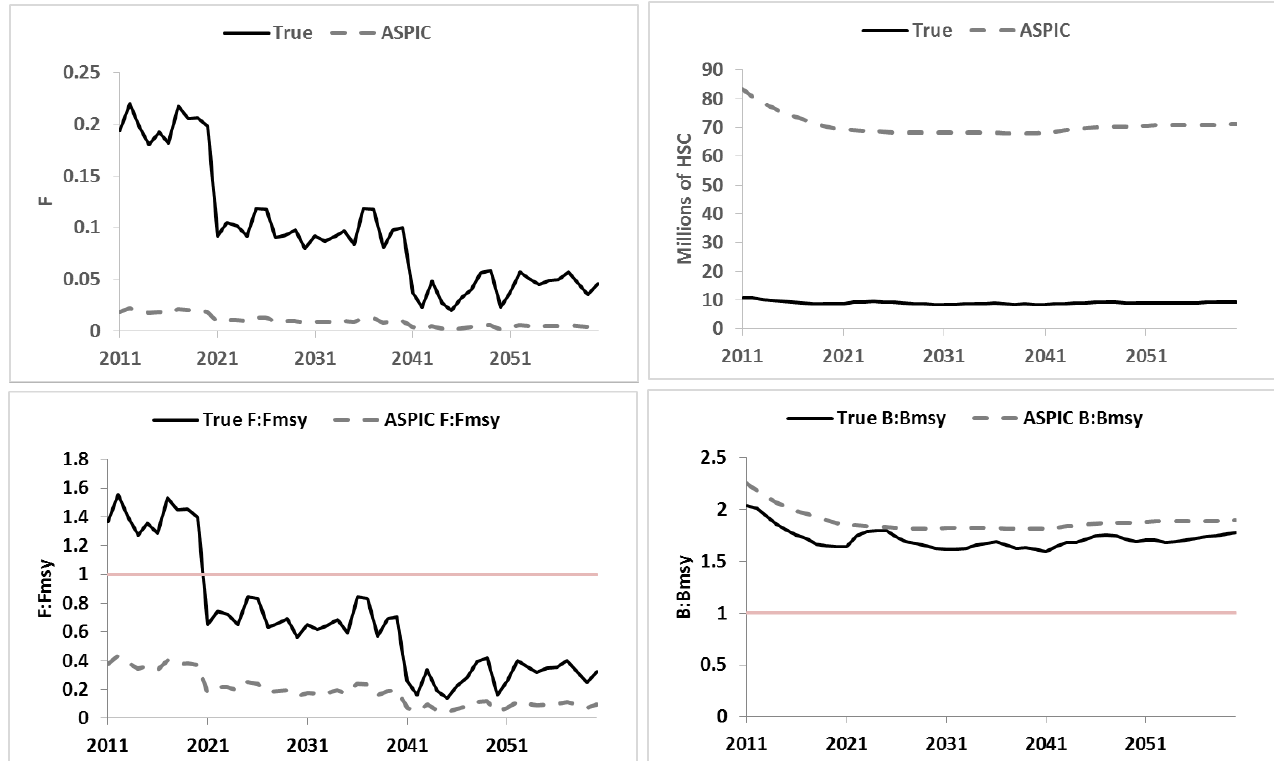
Figure 92. Comparison between simulated “true” data from the operating model and surplus production (ASPIC) results for simulation